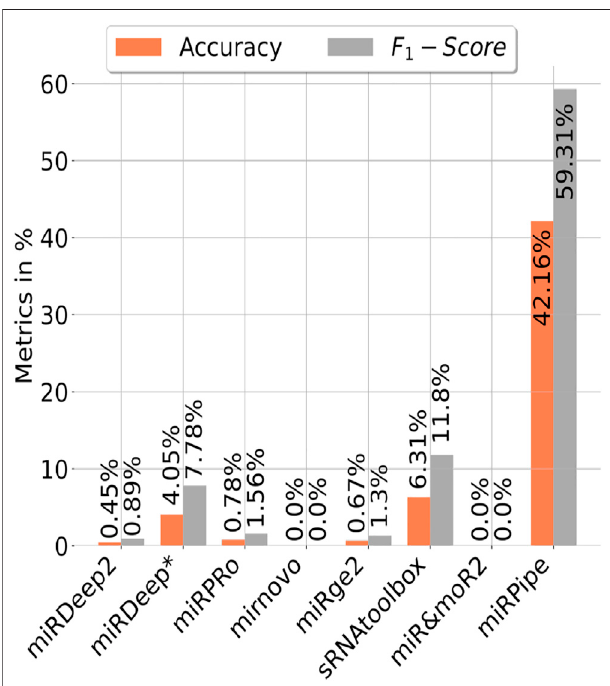
FIGURE5| BenchmarkingofmiRPipewiththesevenstandardpipelines on the identi fi cation of reverse complement miRNA sequence as known miRNA.